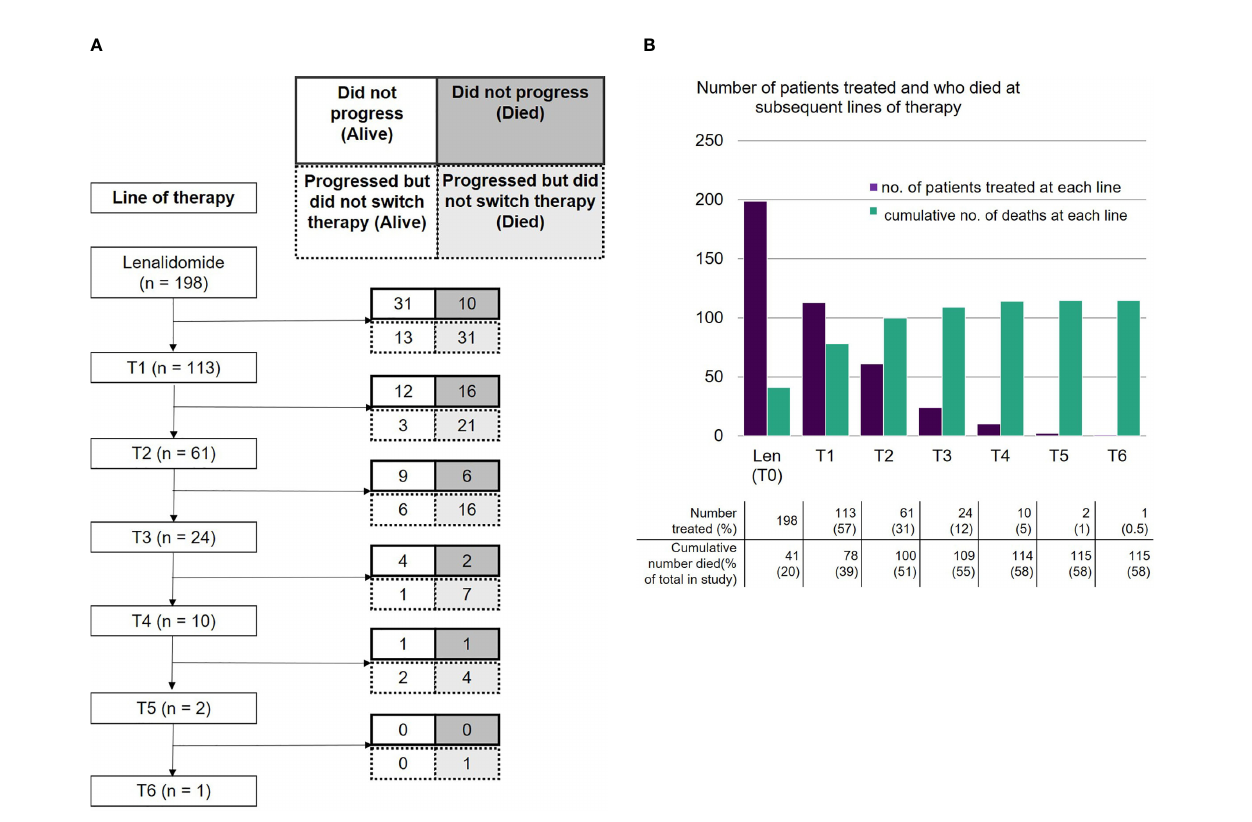
FIGURE 3 | (A) Number of patients receiving lenalidomide-based therapy and each subsequent line, including those who did not progress (alive or died) and those who progressed but did not switch therapy (alive or died). (B) Number of patients who were treated with lenalidomide-based therapy and each subsequent line, and cumulative number of deaths at each